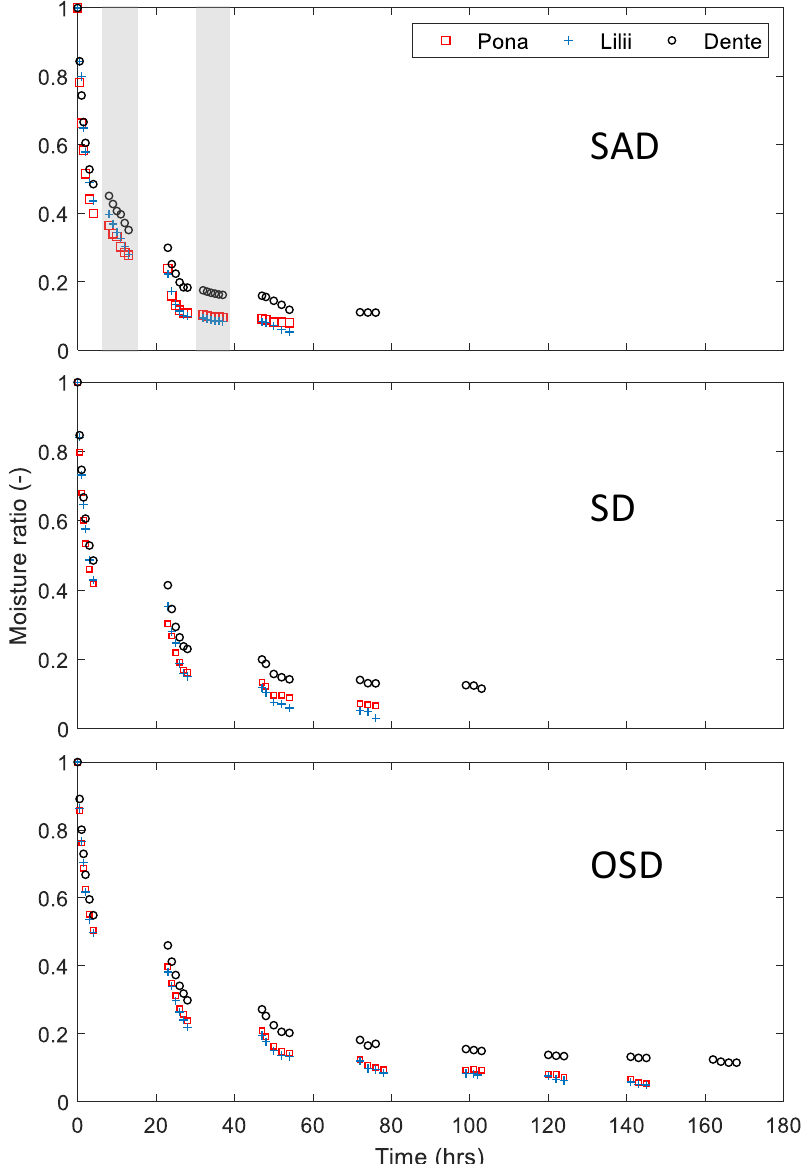
Figure 8. Comparison of drying methods on di ff erent varieties of yam. The grey portions represent night drying.